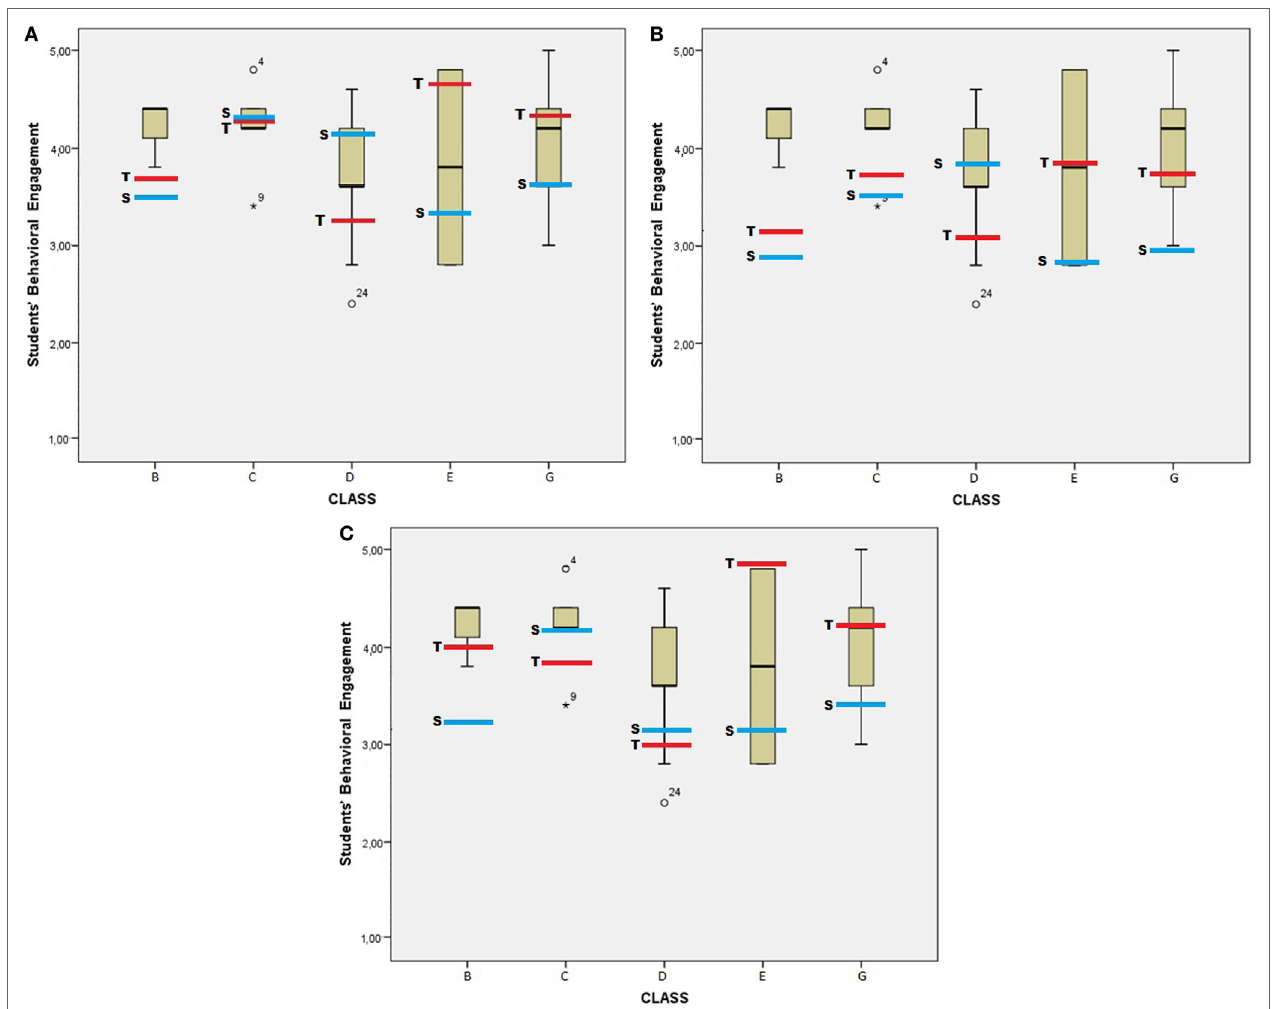
FigUre 4 | Students’ behavioral engagement, teacher-provided and student-perceived (a) structure, (b) autonomy support, and (c)